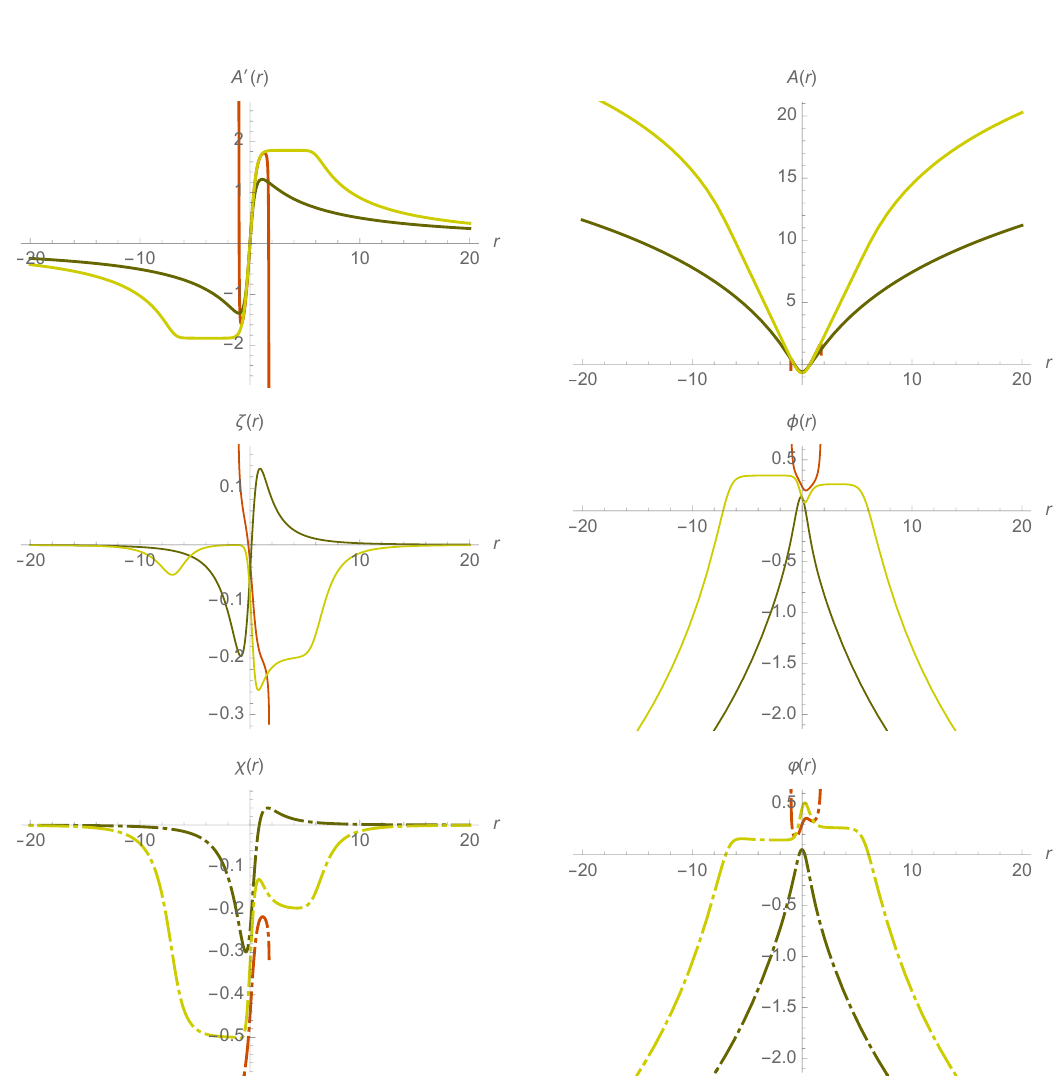
Figure 15. G 2 / U(3) (yellow), SYM/SYM (dark yellow) and singular (dark red) N = 1 Janus solutions with SU(3)